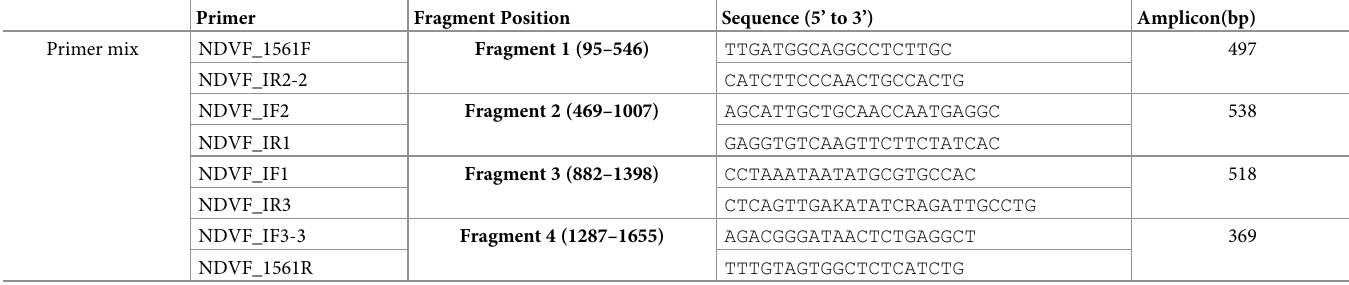
Table 2. NDV Fusion (F) gene tiled fragments and designed PCR